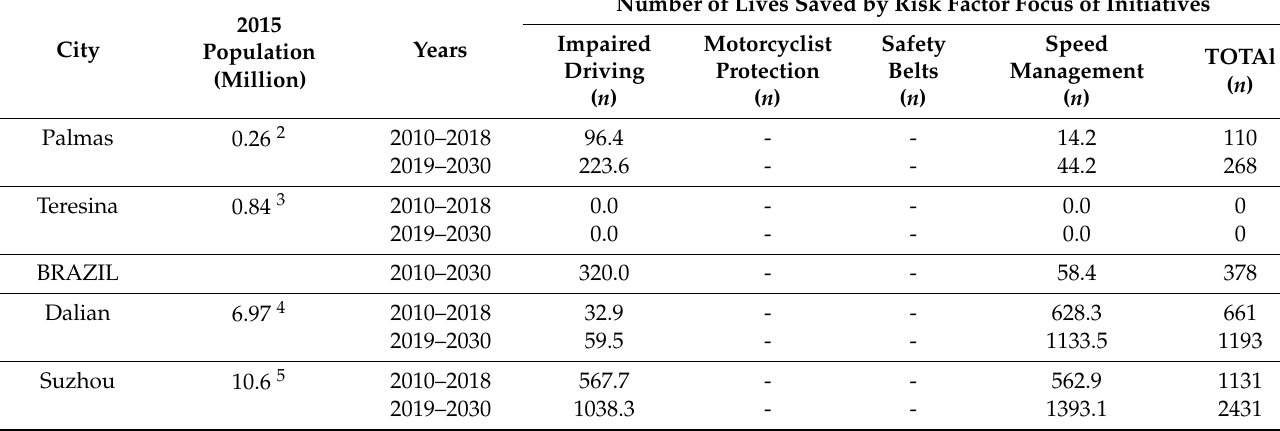
Table A3. GRSP (2010–2014): Estimates of Lives Saved from Social Marketing Campaigns, Police Enforcement, and Related Road Safety Initiatives in the Subnational Areas 1